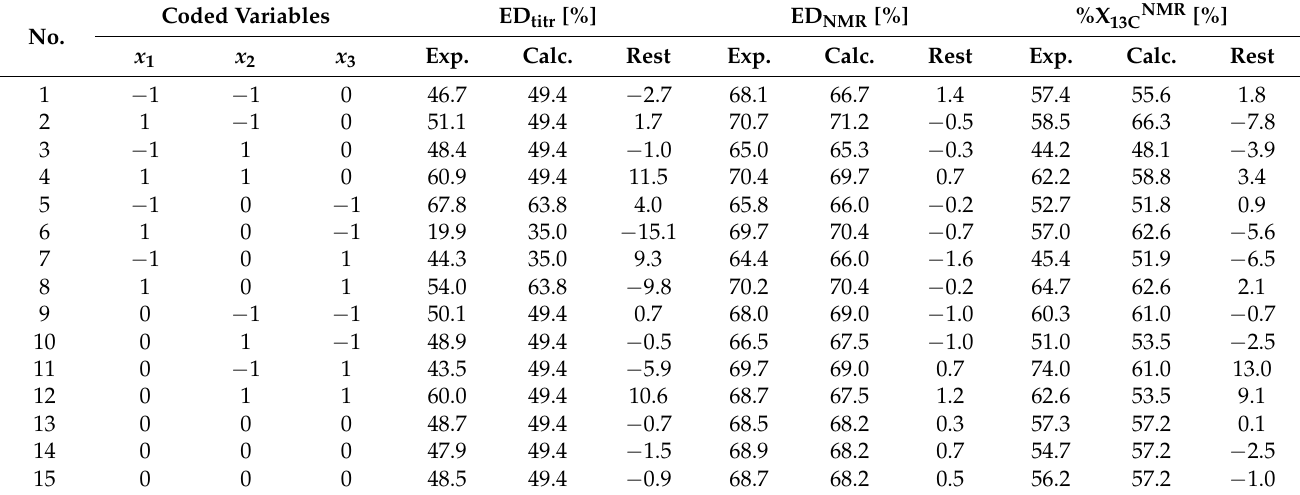
Table 1. Experimental matrix and results (Exp.—experimental, Calc.—calculated). Coded No.